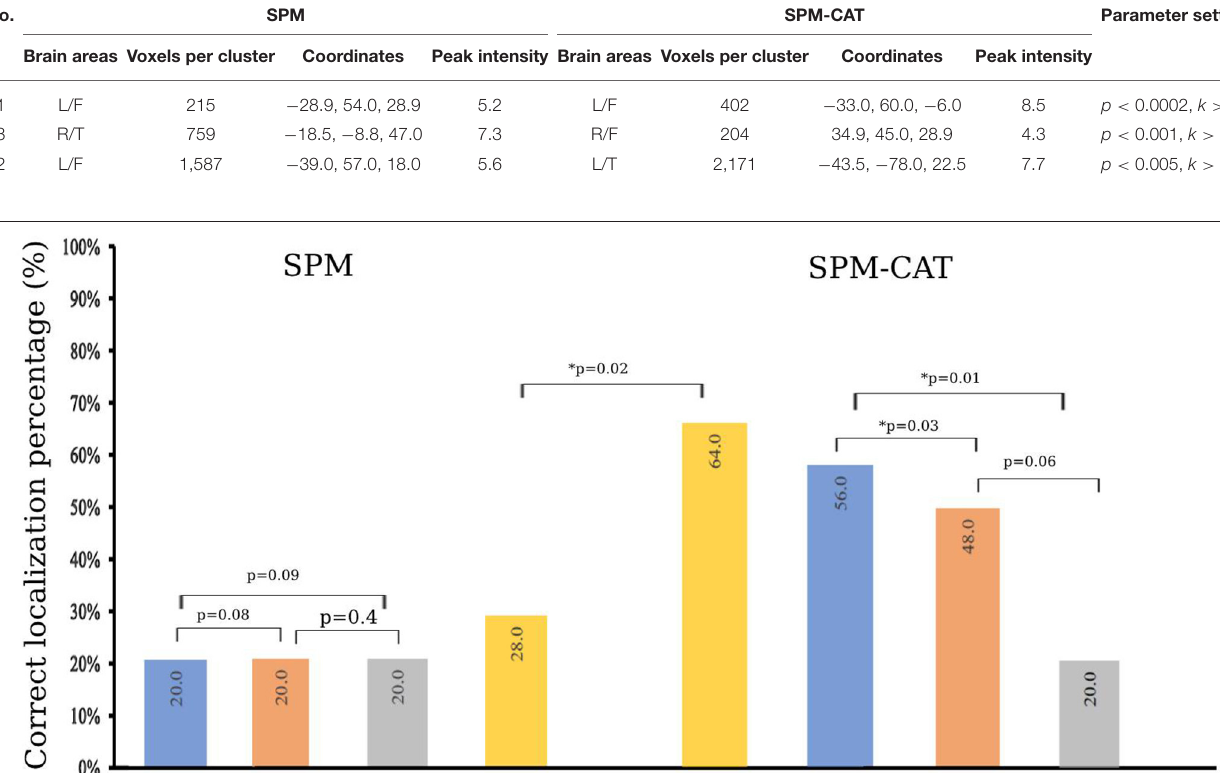
TABLE 3 | Comparison of epileptogenic zones identified by SPM and SPM-CAT (cluster with largest volume) in three patients as examples. No.